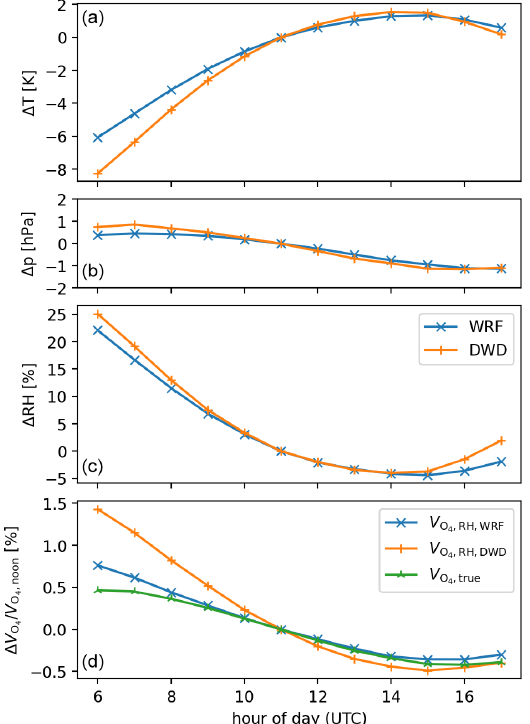
Figure 12. Diurnal cycles of surface temperature (a) , pressure (b) , RH (c) , and the O 4 VCD (d) . Data points show the mean values for all stations for May to June 2018 for days where the increase in T 0 (from DWD) over the day is larger than 10K. For better compari- son, the mean value at 11:00UTC (around solar noon for Germany) is subtracted from all datasets. For the O 4 VCD, the relative change is